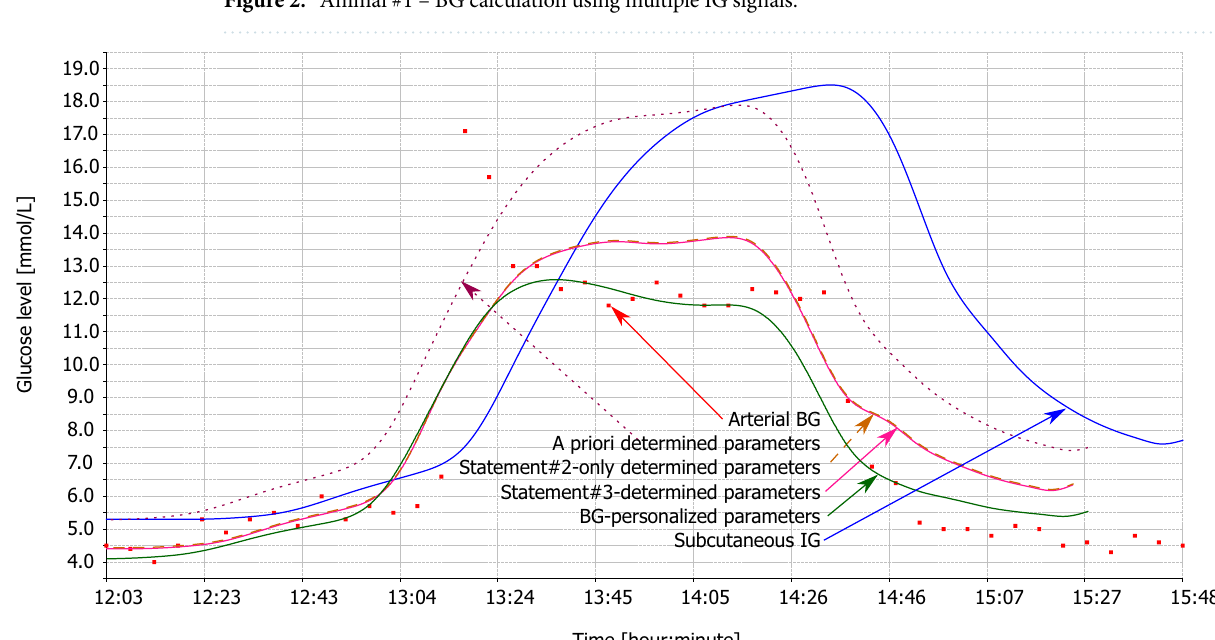
Figure 3. Animal #1 – BG calculation using individual IG